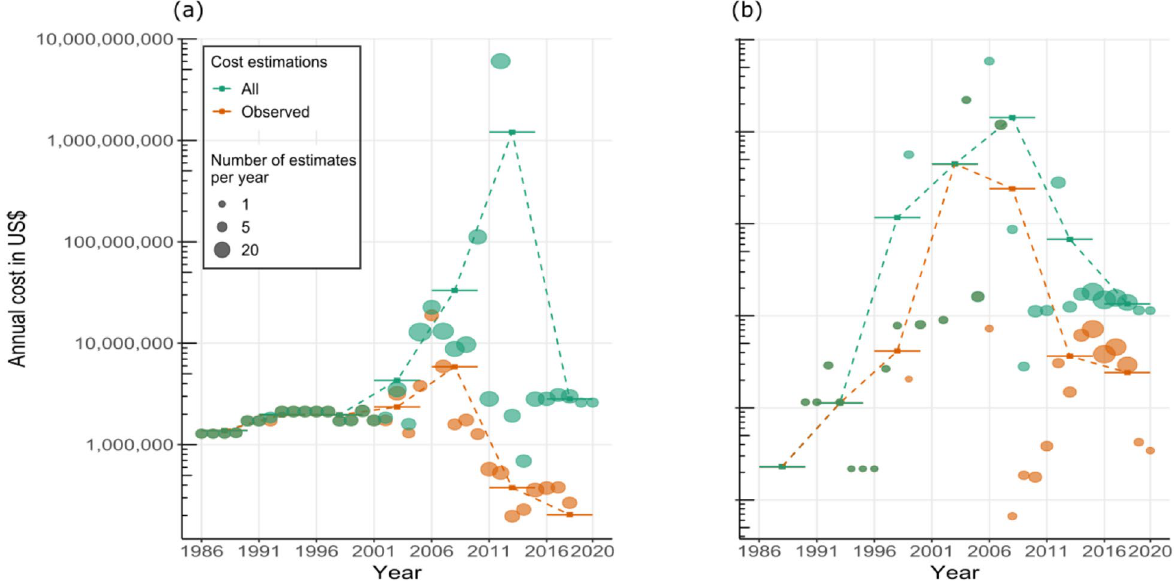
Figure 5. Total annual cost in US$ 2017 for ( a ) amphibians and ( b ) reptiles. The green colour represents all costs ( Observed plus Potential ), while the orange colour represents only Observed costs. The size of the circle indicates the number of estimates per year. Bars represent means for each 5-year period. Note that the y-axes are on log 10